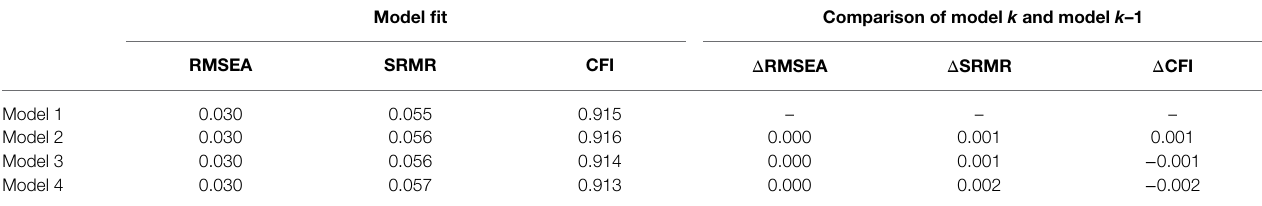
TABLE 9 | Test for child gender invariance.